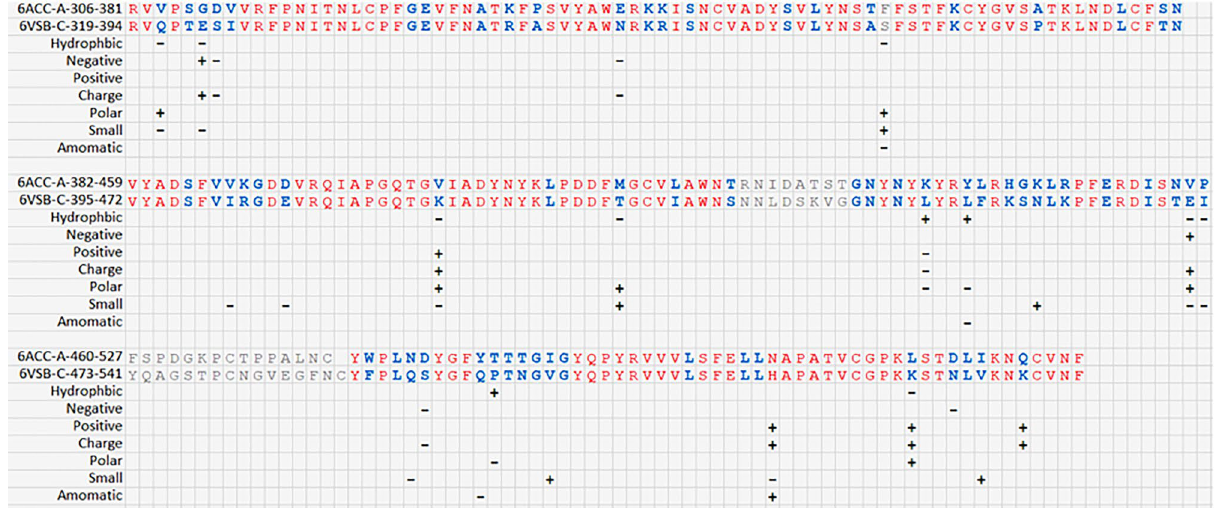
Table 2. The change of physicochemical properties due to mutations from sequence of 6ACC for SARS-CoV to 6VSB for SARS-CoV-2. The two rows on top are sequences of 6ACC and 6VSB, and the residues in red are highly conserved, blue are less conserved and gray are unaligned. The physicochemical properties are listed in the left column. The “ + ” sign indicates an increase in the property after mutation; the “−” sign indicates a decrease in the property after mutation.